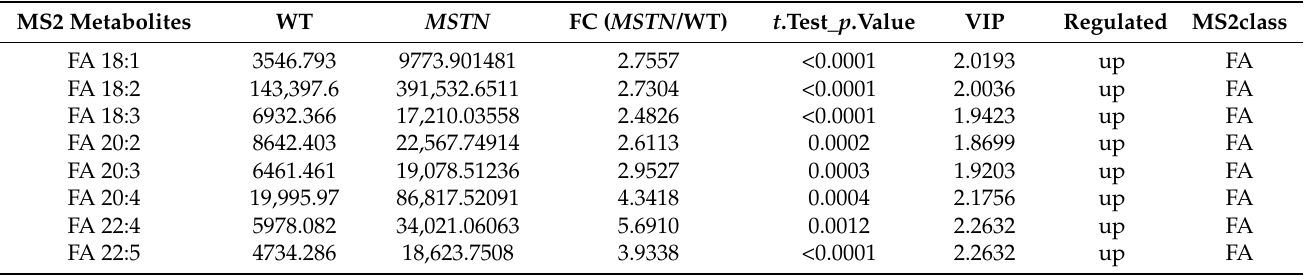
Table 2. Significantly differently expressed fatty acyls in the MSTN +/ − versus the WT pigs.